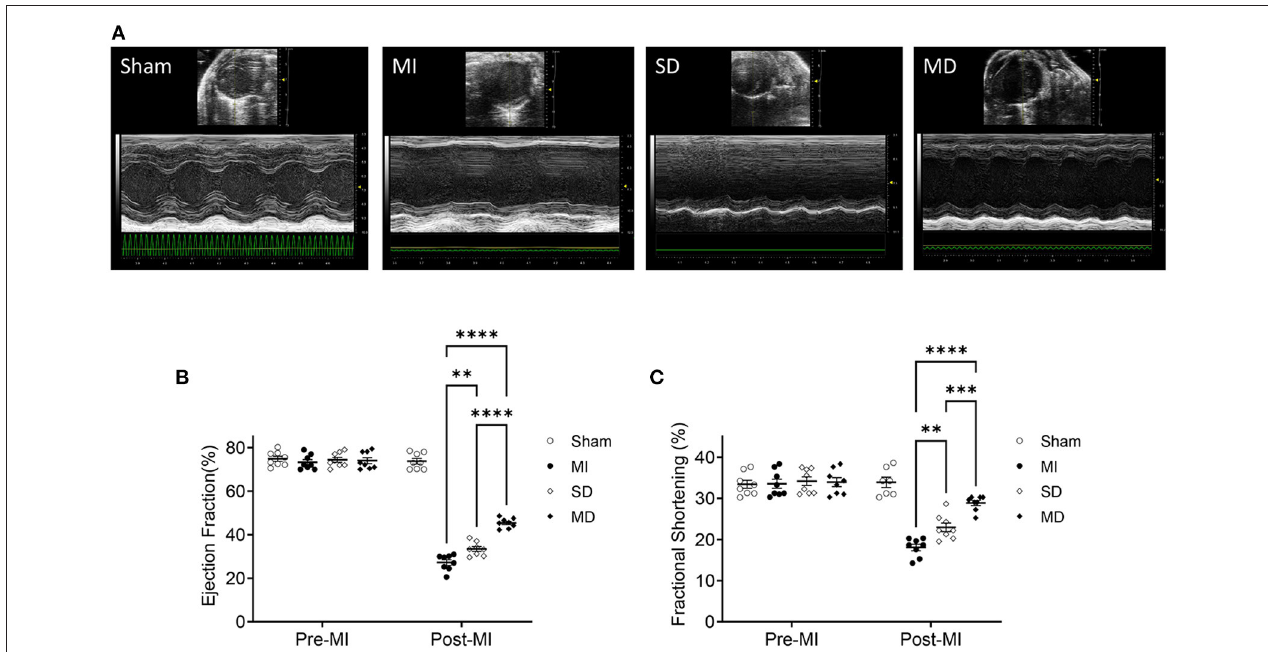
FIGURE 2 | Assessment of cardiac function. Use high-resolution echocardiography to assess left ventricular function before MI induction (pre-MI) and 4 weeks after treatment (A) . The ejection fraction (B) and fractional shortening (C) are presented as absolute values. Data are means ± SE. Eight animals per group. One-way ANOVA with Dunn’s multiple comparisons test. ** p < 0.01; *** p < 0.001; **** p <